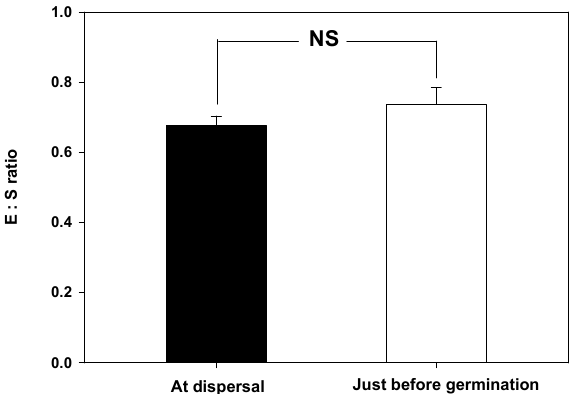
Figure 3. Embryo to seed (E:S) ratio of Vacinnium oldhamii at dispersal and before germination, Error bars indicate the mean ± standard error (n = 10). Each E:S ratio at dispersal and prior to germination was compared using a paired t-test (NS: no significant).